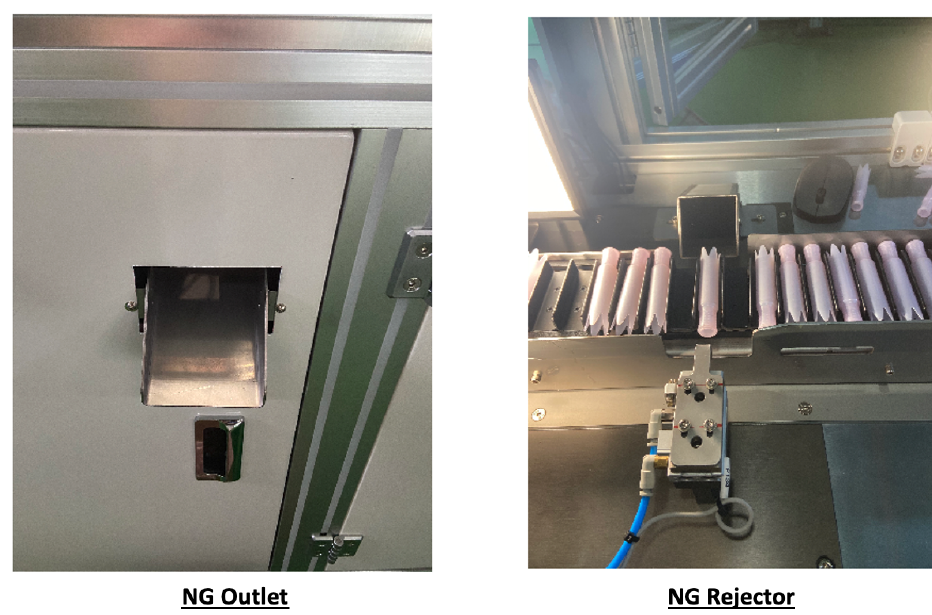
Figure 21. NG outlet and